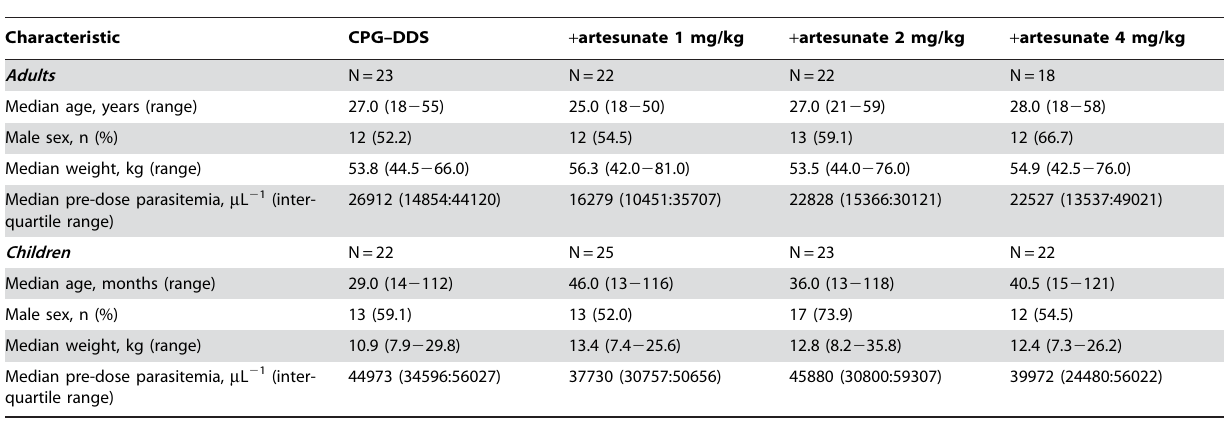
Table 1. Baseline demographic and clinical characteristics of the Day 3 per-protocol